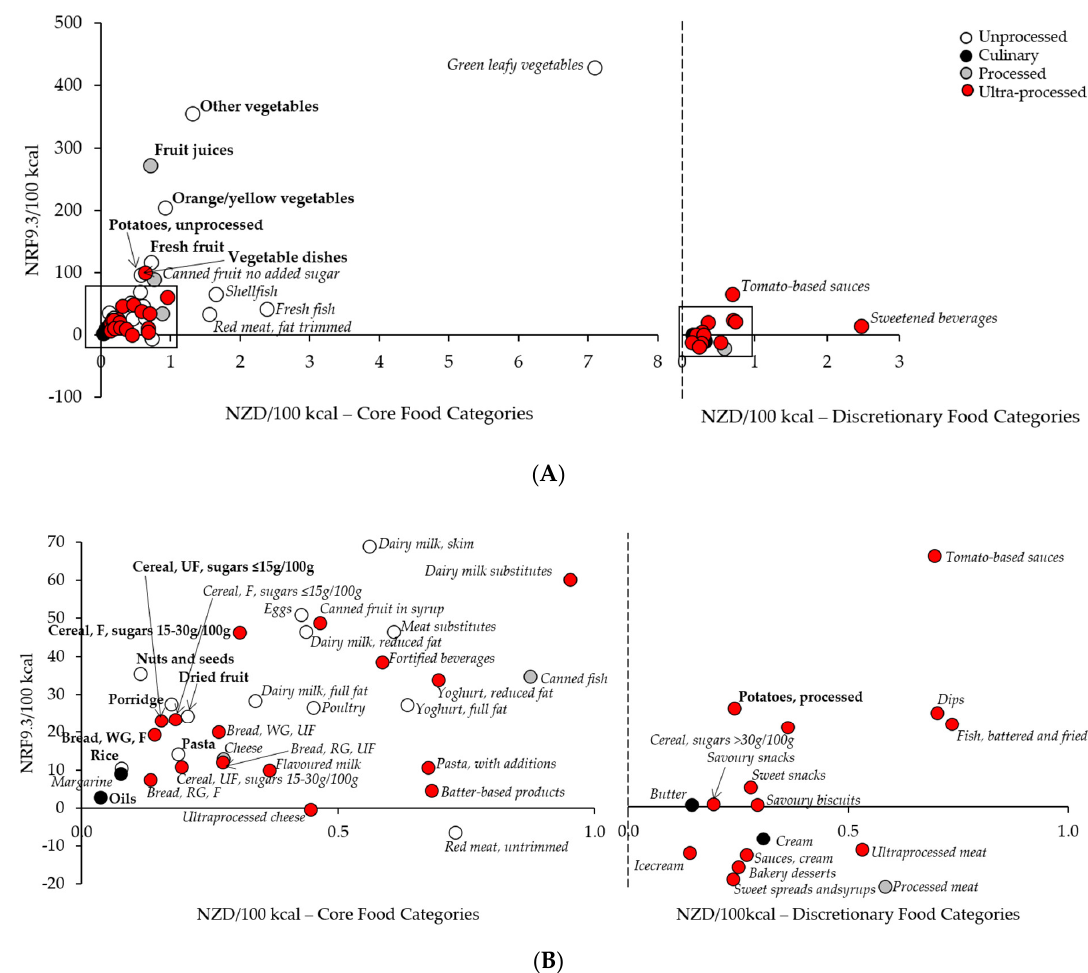
Figure 2. Nutrient density (NRF9.3 per 100 kcal) vs cost (NZD per 100 kcal) for the 61 NZ food categories ( A ) Complete graph showing the relationship between nutrient density and cost for all 61 food categories, separated as core or discretionary food categories. The majority of food categories are clustered with an NRF 9.3/100 kcal less than 70 and a cost (NZD)/100 kcal) less than NZD 1.0 (boxed areas). ( B ) Enlargement of the clustered food categories contained within the boxes in Figure 2A for each core and discretionary food category. For both A and B, the food categories appearing in the highest quartile of the nutrient density-to-cost ratio are shown in bold, and food categories in quartiles 2–4 are in italics. Unprocessed food categories are shown as white circles, culinary processed as black circles, processed as grey circles, and ultra-processed as red circles. Figure abbreviations: F, fortified; RTE, ready-to-eat; RG, refined grain; UF, unfortified; WG, wholegrain. Potatoes, unprocessed: includes unprocessed potatoes and red kumara; Potatoes, processed: includes processed potatoes and red kumara.